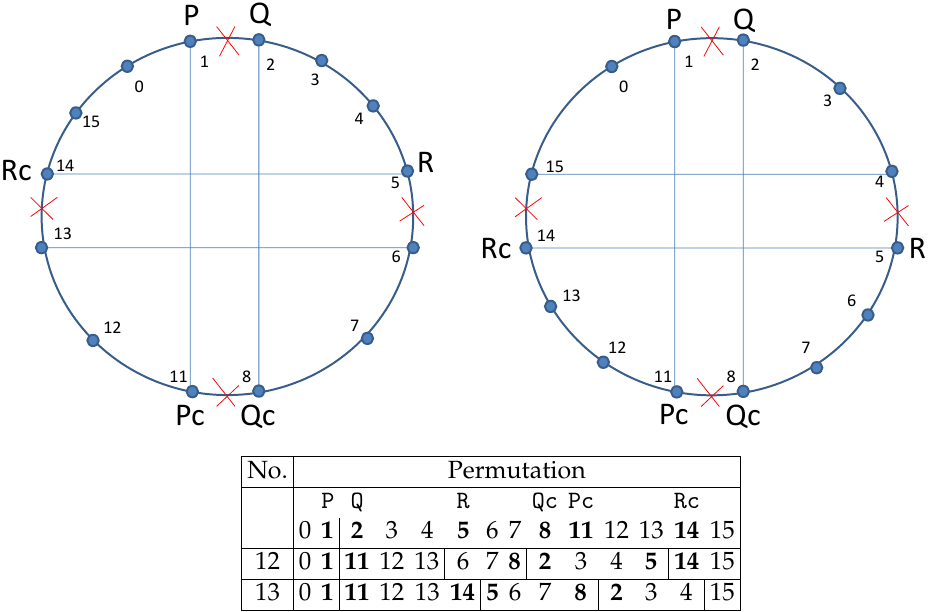
Figure 5. Special 4-opt permutation in two variants: “double-bridge